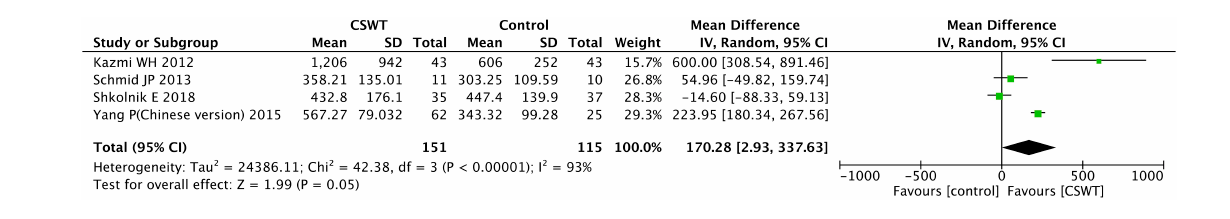
FIGURE11 Forest plot of the CSWT group vs. the control group-exercise duration.